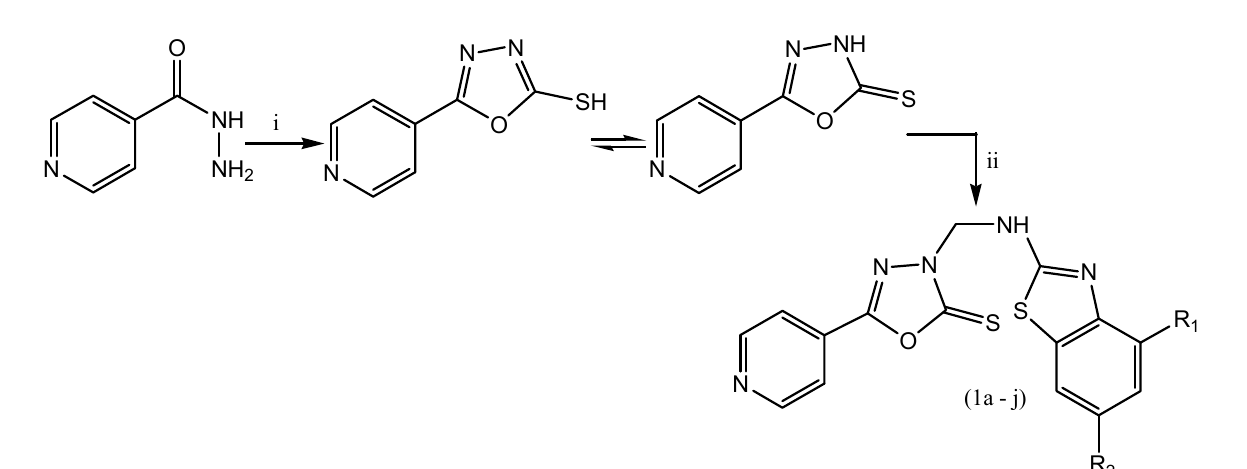
Scheme 11. Synthesis of 3-((substituted-benzo[d]thiazol-2-ylamino)methyl)-5-(pyridin-4-yl)-1,3,4-oxadiazole-2( 3h )-thi-